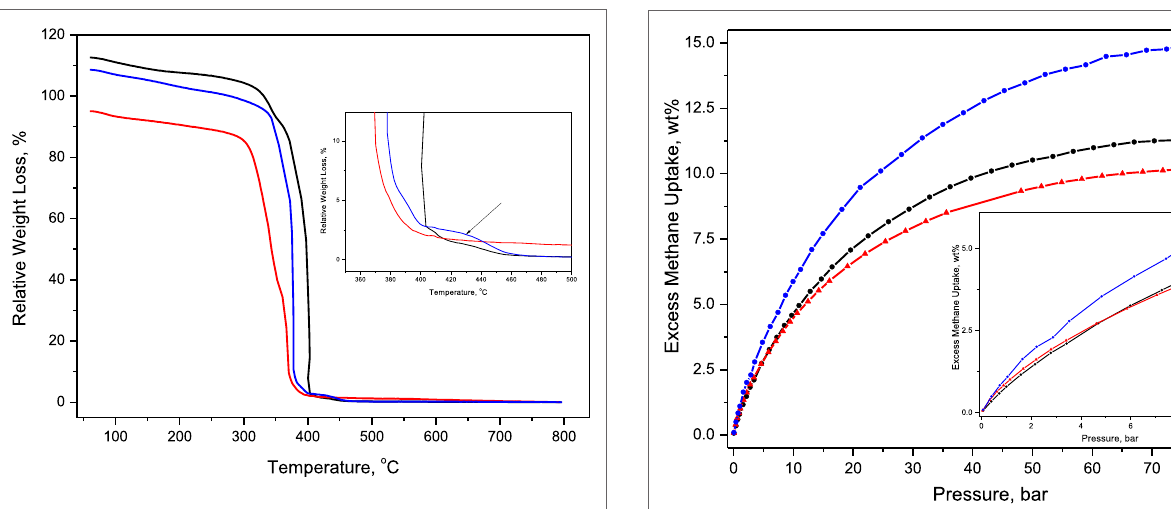
FigUre 3 | normalized Tga curves for Mil-101 (black), nh 2 -Mil-101 (red), and PsM (blue), highlighting the additional decomposition step at ca. 430°c in the insert . One hundred percent of relative weight loss corresponds to the perfectly pure, crystalline, and completely dehydrated MOF → Cr 2 O 3 reaction, normalized to the molar mass of the samples. The first degradation step of the functionalized MOFs occurs at lower temperatures than that of the pristine MIL-101, which corresponds to the breaking off of the − NH 2 functional group.